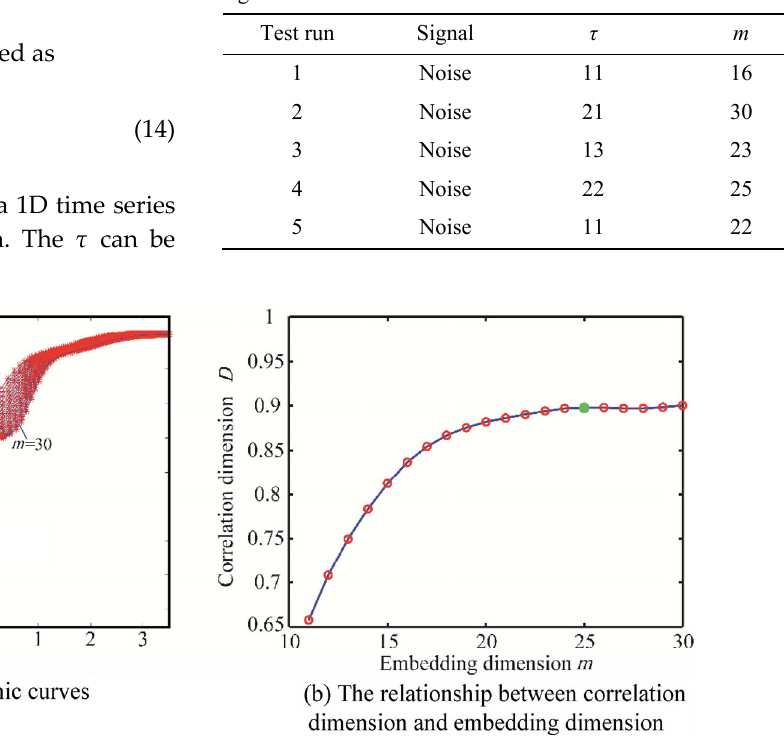
Fig. 7 Solution of embedding dimension of friction noise from test 4 ( v = 0.911 m/s, P = 0.301